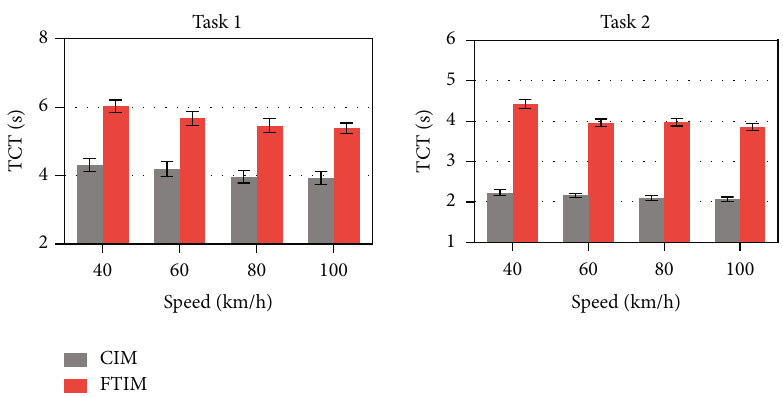
Figure 6: The framework of gray correlation analysis.